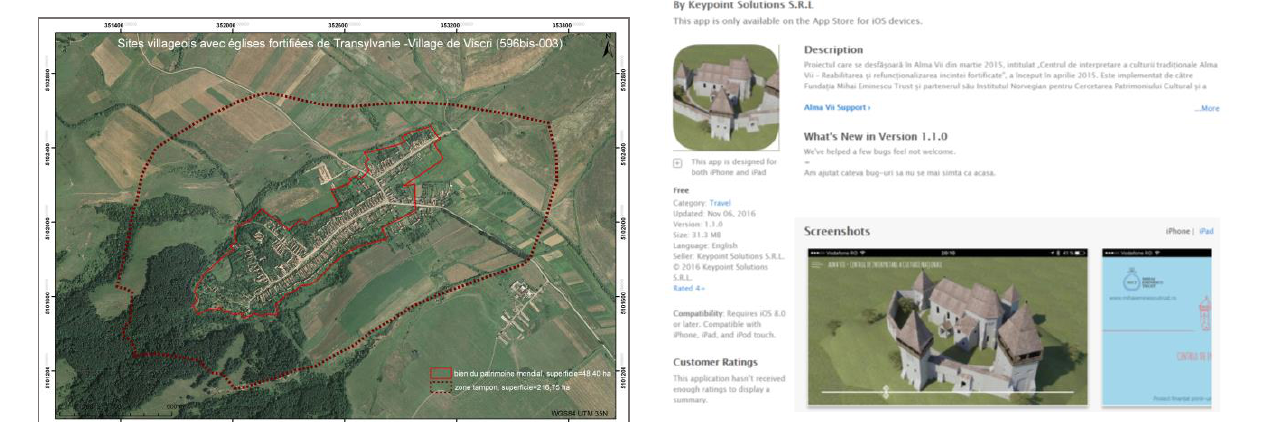
Figure 15. App-example of promoting resource, Alma Vii village.